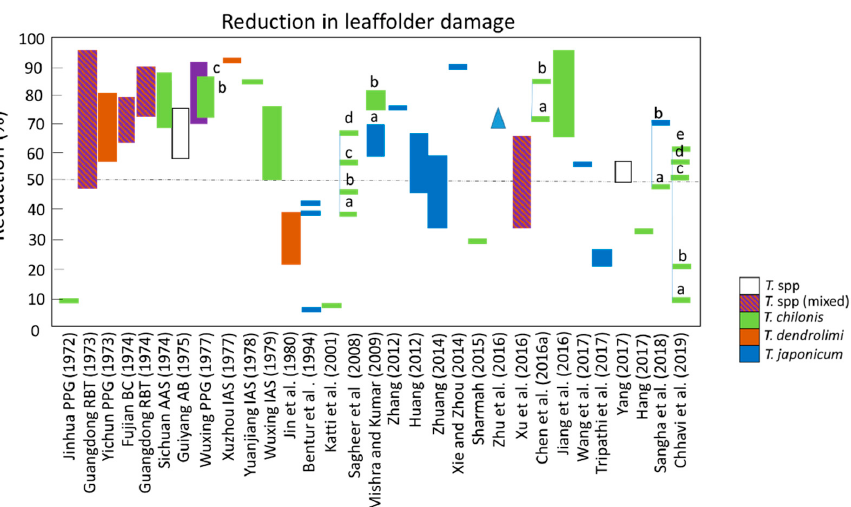
Figure 4. Reductions in rice damage from leaffolders due to Trichogramma -based biological control releases as reported for a range of field studies. Bar colors indicate Trichogramma species as indicated in the legend. The triangle indicates ‘equal to or greater than’. Note that some studies compared Trichogramma species (indicated by lowercase letters associated with different species in the same study) or compared different release densities (indicated by lowercase letters associated with the same species in one study; i.e., Sagheer et al. (2008b) [105], a = 50 K, b = 75 K, c = 100 K, d = 125 K released; Chen et al. (2016) [82], a = 90 K, b = 144 K; Chhavi et al. (2019) [104], a = 50 K, b = 75 K, c = 100 K, d = 125 K, e = 150 K). Damage reductions indicated for Bentur et al. (1994) [88] correspond to 1991 results for Hyderabad (42%), Nawagam (38.5%) and Pondicherry (8%) (See Table S1 for further details).